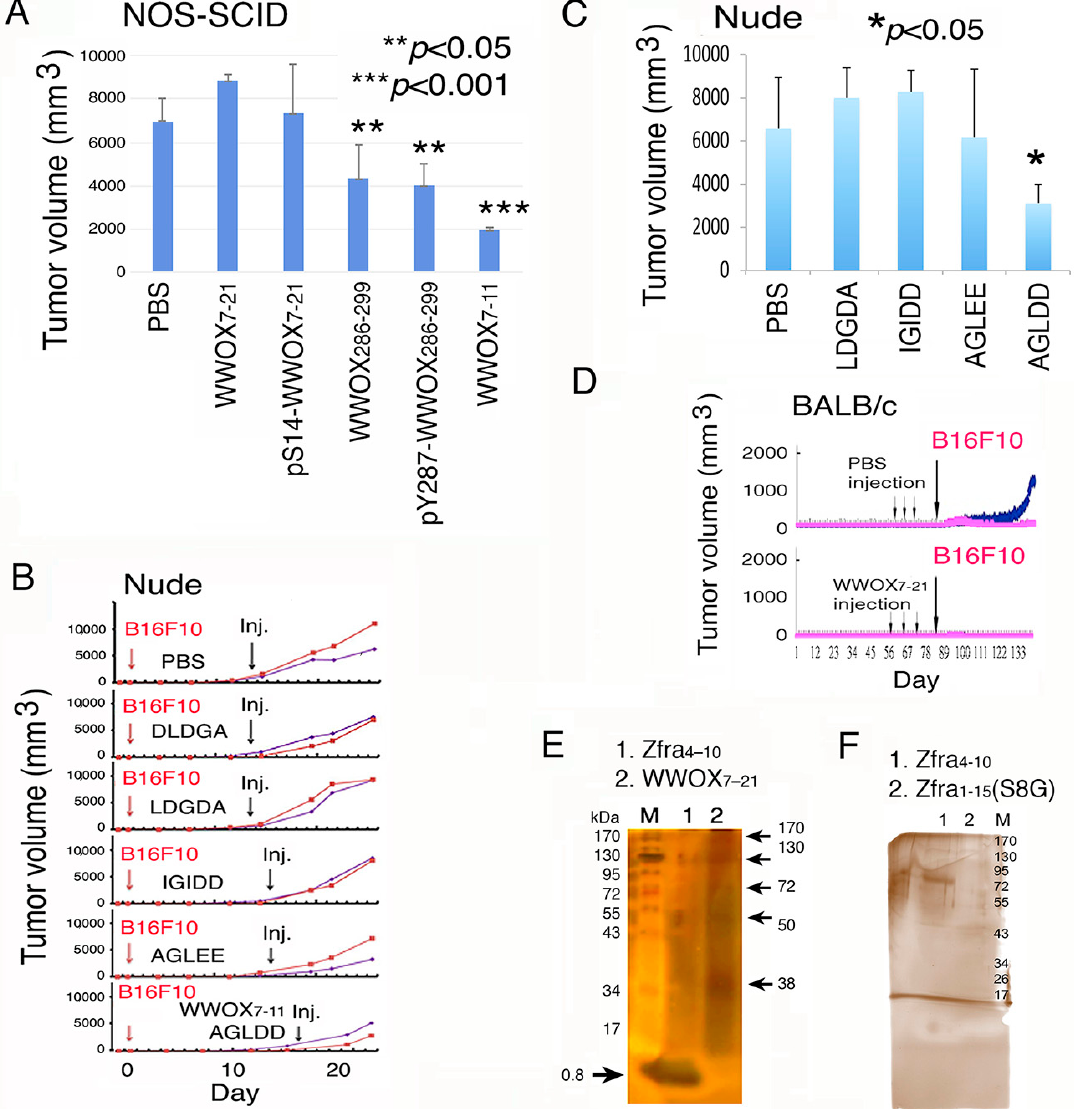
Figure 2. WWOX7-11 peptide is most potent in suppressing cancer growth in vivo ( A ) Each NOD-SCID mouse received an indicated peptide via subcutaneous injection in one side of the flanks, and B16F10 cells inoculated simultaneously in the other side. WWOX7-11 blocked B16F10 growth ( n = 3; mean ± SD). ( B , C ) Scrambled peptides of WWOX7-11 (AGLDD) did not block melanoma growth in nude mice ( n = 4; mean ± SD). The tumor growth curves and the end-point tumor sizes are shown. ( D ) BALB/c mice received tail vein injections of WWOX7-21 once per week for 3 consecutive weeks, followed by inoculating cancer cells in both flanks. The growth of B16F10 cancer cells was blocked (representative data from 2 experiments). ( E ) Zfra 4-10 and WWOX 7-11 peptides were resuspended in sterile Milli-Q water (400 µM), and allowed to sit for 3 h in the room temperature. Partial self- polymerization of the peptides is shown. ( F ) Under similar conditions, Zfra 4-10 and Zfra 1-15 (S8G) were resuspended in PBS and incubated at room temperature for 3 h. Zfra 4-10 underwent polymerization, and the S8G mutant failed to polymerize.